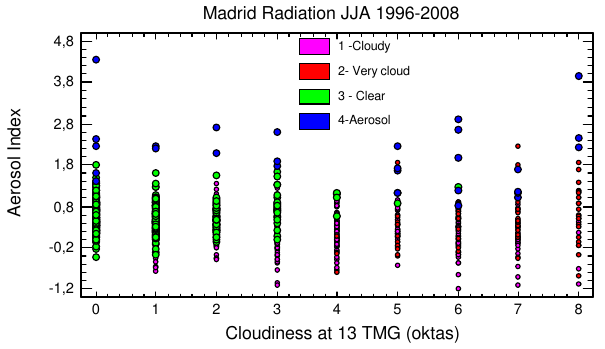
Figure 2. Scattergram satellite aerosol index versus cloudiness at 13 hours TMG measured in Fig. 2. Scattergram satellite aerosol index versus cloudiness at 13h oktas over Madrid in June-July-August for every day with satellite TOC and AI selected value TMG measured in oktas over Madrid in June-July-August for every from EP TOMS and OMI instruments in the period 1996-2008. Four clusters classification day with satellite TOC and AI selected value from EP TOMS and OMI instruments in the period 1996–2008. Four clusters classifi- based on global, direct, diffuse radiation values and cloudiness at 13 TMG over Madrid plus cation based on global, direct, diffuse radiation values and cloudi- Aerosol Index from satellite overpasses over Madrid. ness at 13 TMG over Madrid plus Aerosol Index from satellite over- passes over